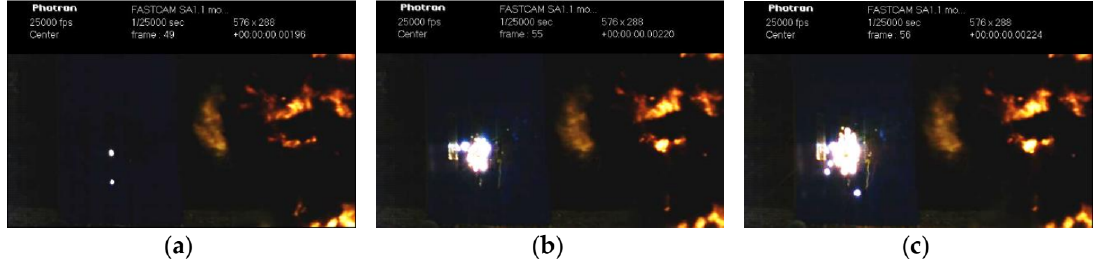
Figure 7. High-speed photography record of the D-120 ◦ experiment I. ( a ) 2# target plate ( t = 1.96 ms); ( b ) 3# target plate ( t = 2.20 ms); ( c ) 1# target plate ( t = 2.24